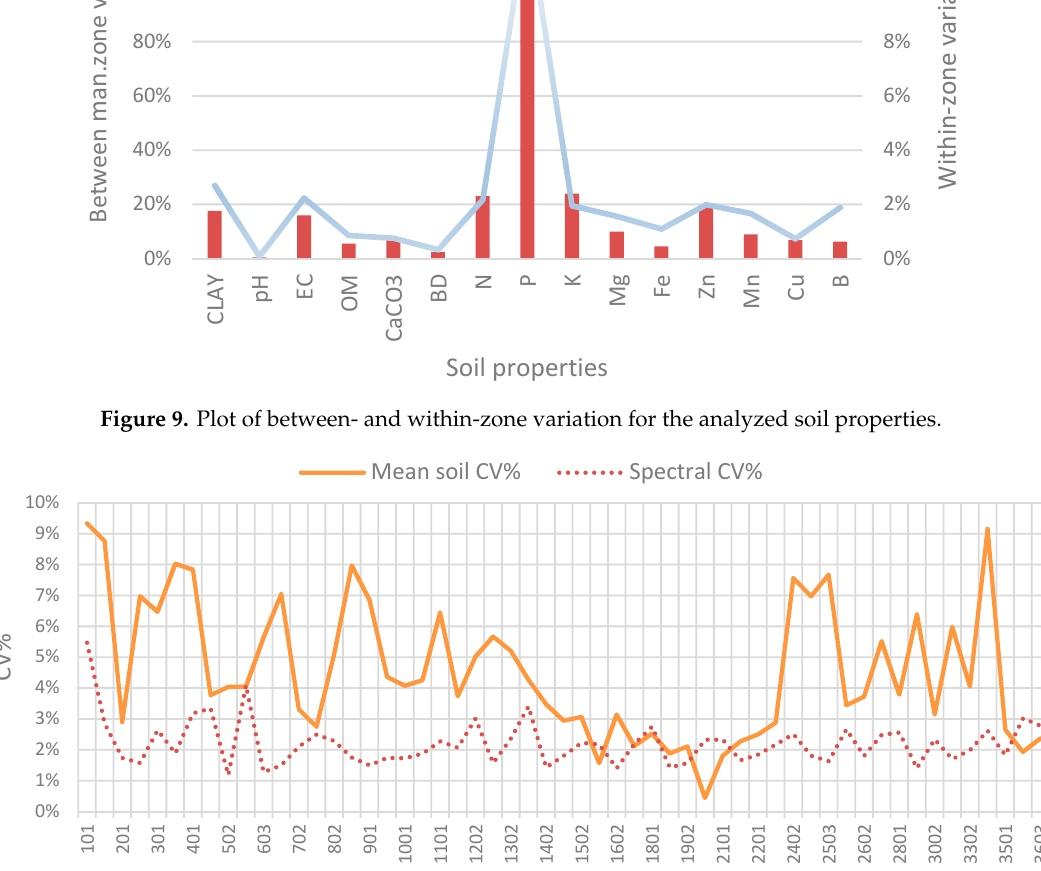
Figure 10. Plot of within-zone mean soil and spectral variation.